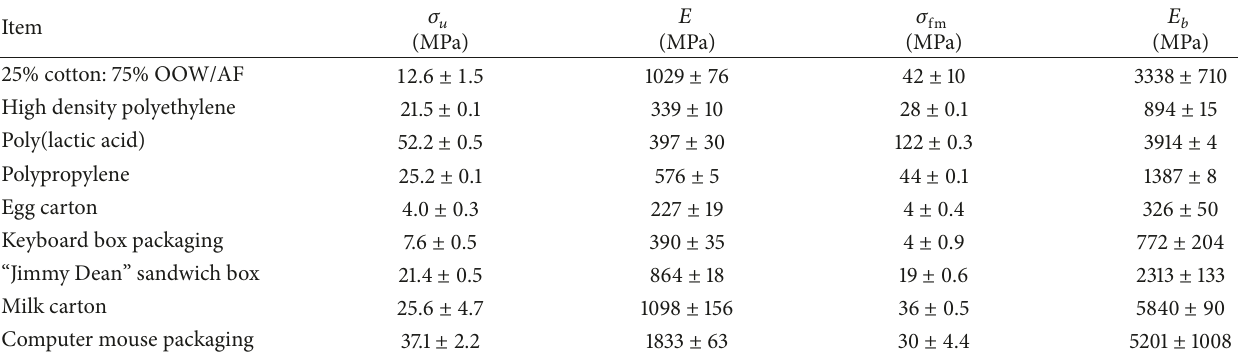
Table 4: Comparison of various commercial composites and plastics mechanical properties used for packaging ∗ .